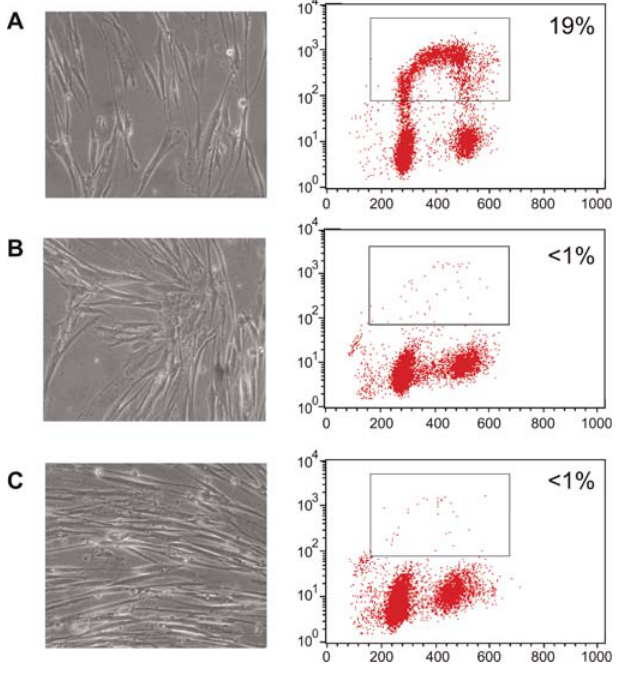
Figure 7. Cells Arrested by CKI Overexpression